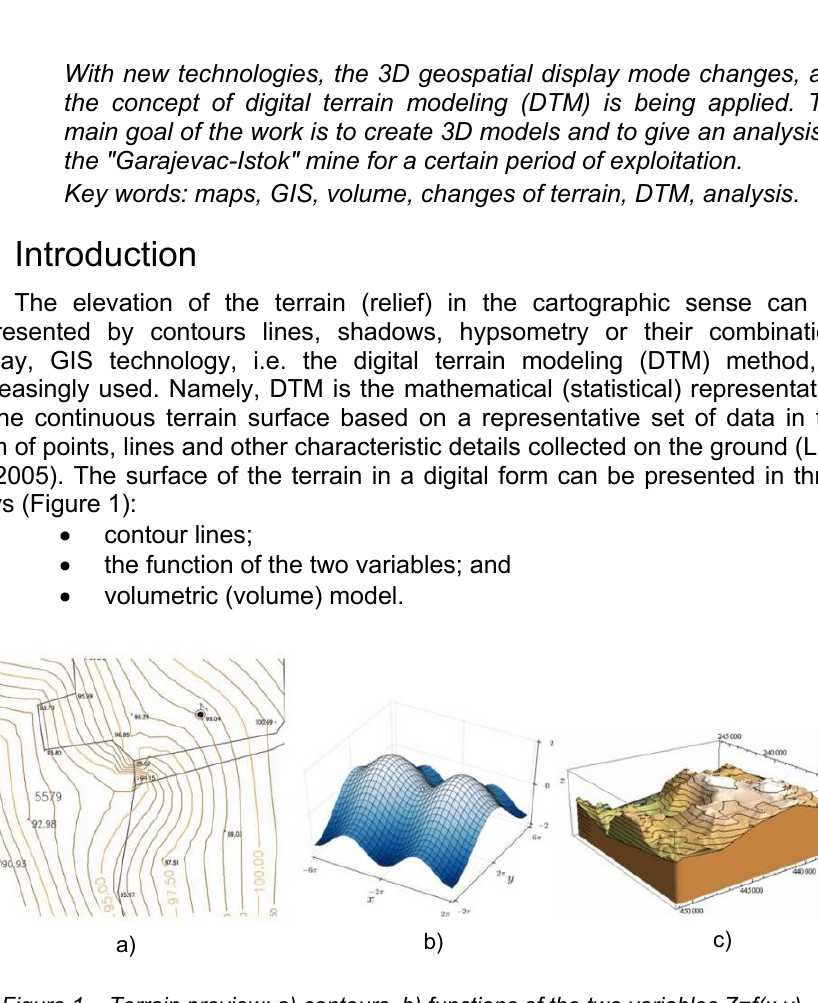
Figure 1 – Terrain preview: a) contours, b) functions of the two variables Z=f(x,y), c)